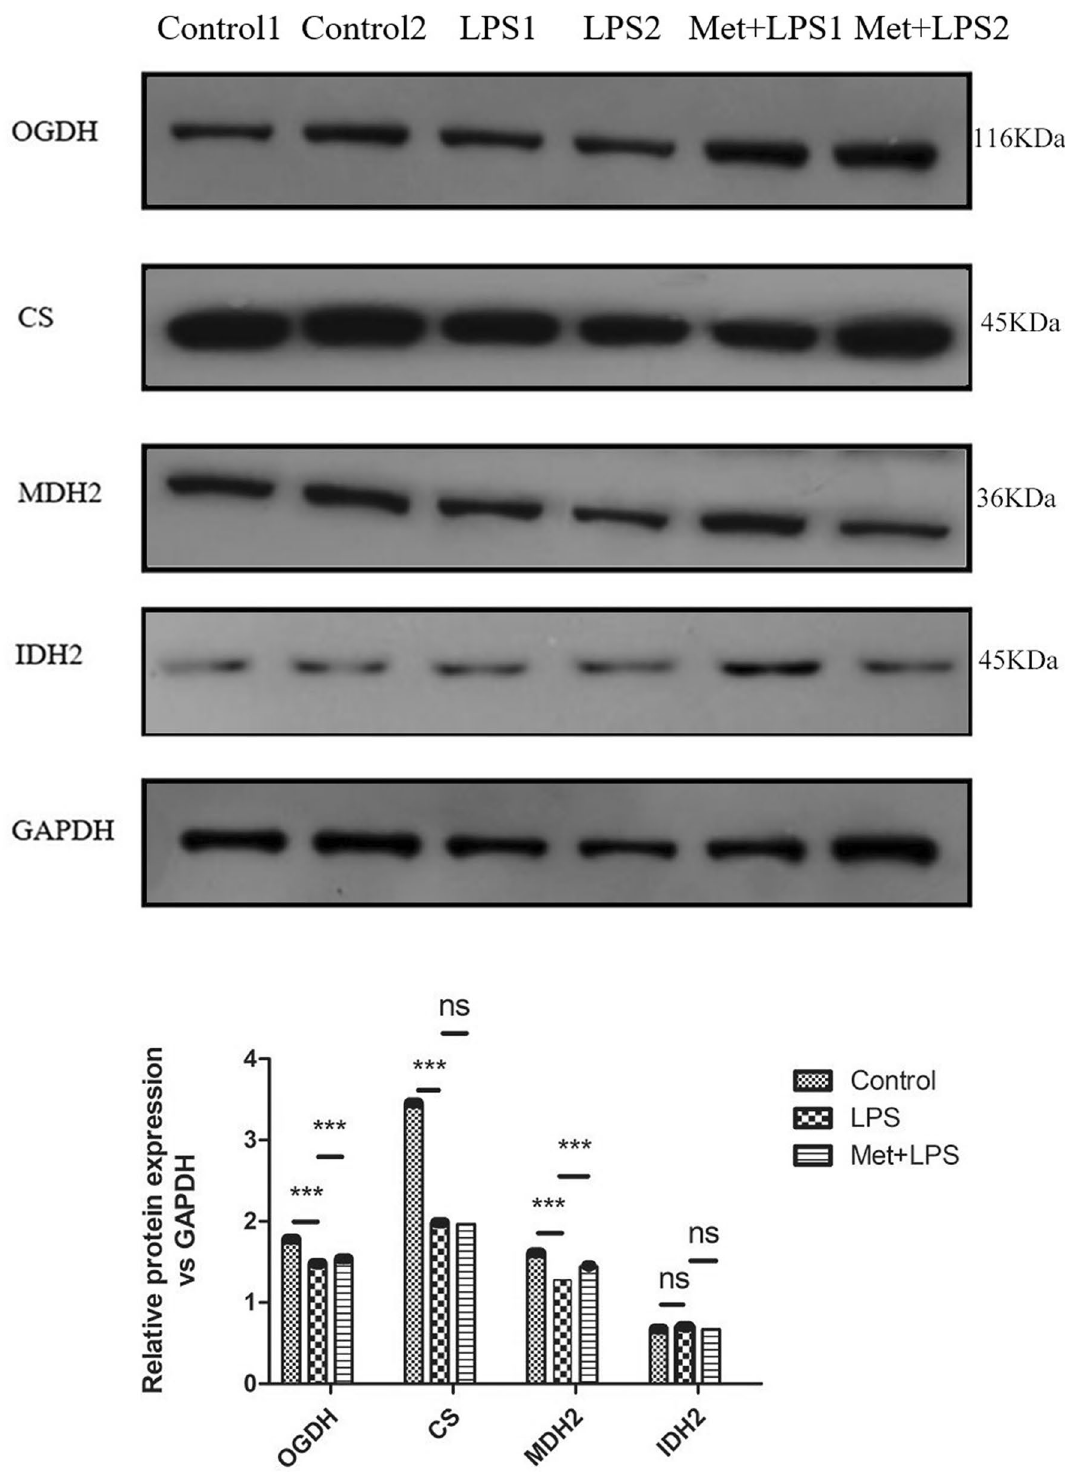
Figure 8. The protein expression levels of tricarboxylic acid cycle key enzymes in macrophages in mice treated with lipopolysaccharide and metformin. GAPDH: glyceraldehyde-3-phosphate dehydrogenase, LPS: lipopolysaccharide, Met: Metformin, CS: citrate synthase, IDH2: isocitrate dehydrogenase 2, MDH2: malic dehydrogenase 2, OGDH: α-ketoglutarate dehydrogenase. LPS group: compared with blank control group. Met + LPS group: compared with LPS group. * P < 0.05, ** P < 0.01: *** P < 0.0001. ns no